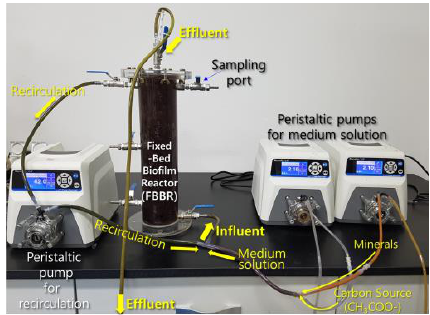
Figure 1. Schematic diagram on a picture of the fixed-bed biofilm reactor (FBBR)